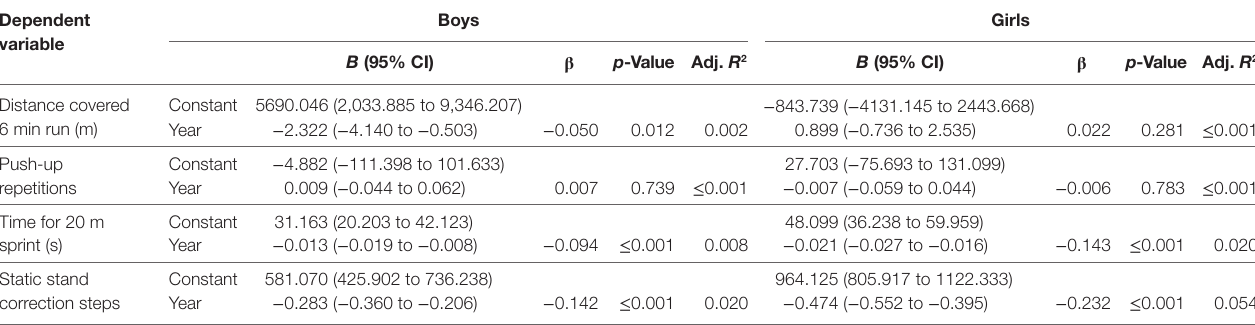
TaBle 2 | Results of linear regression analyses for boys and girls separately.